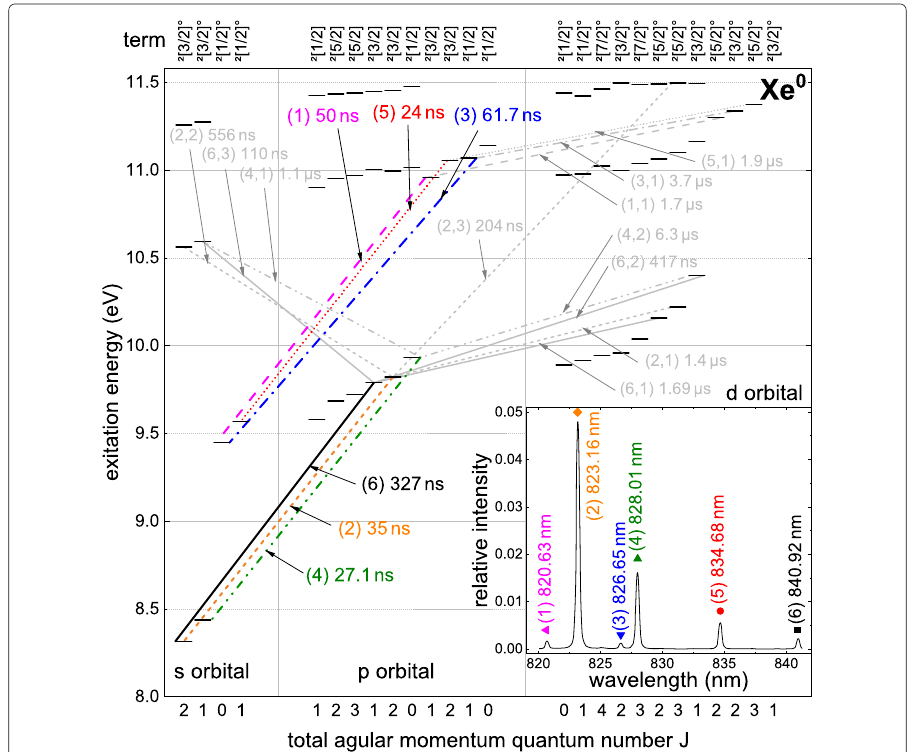
Fig. 4 The measured spectral range from 820nm to 841nm exhibits six xenon transitions, which are shown in the energy level scheme for neutral xenon generated from the data from Ref.[41]. A corresponding example spectrum is shown in the inset. The strongest transitions feeding the upper levels of the observed transitions are also shown. The relaxation times of the transitions are given according to Ref.[43]. Using the labeling given in the figure, the transitions can be found in Table 1 for additional